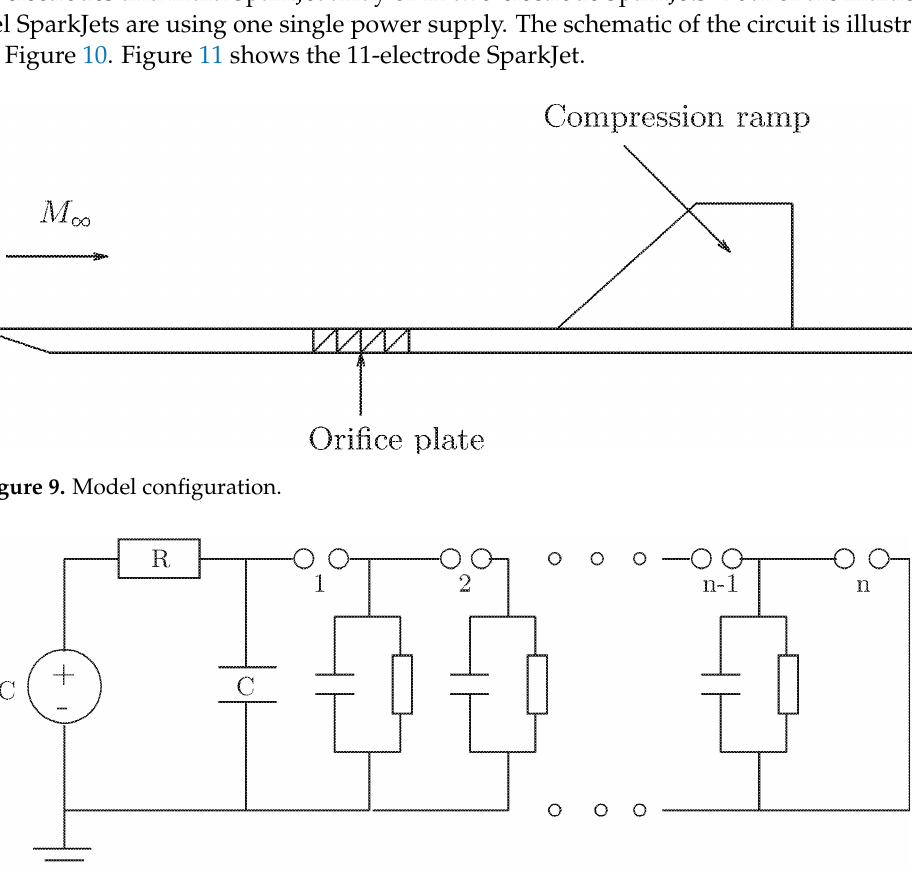
Figure 10. Schematic of the multichannel SparkJet